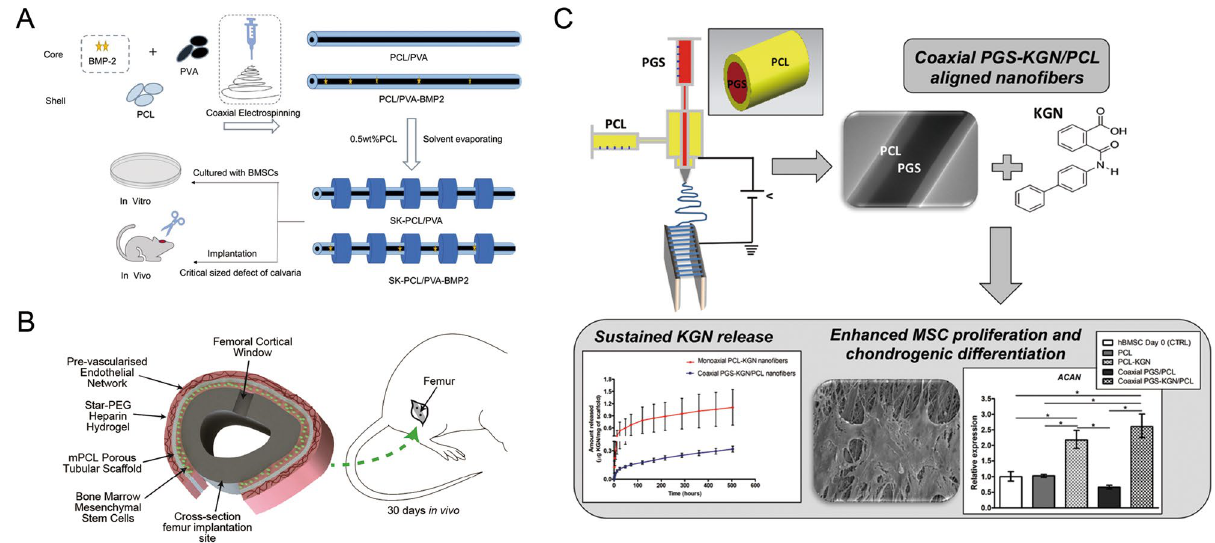
Fig. 3 a Preparation and application of shish-kebab (SK) struc- ture electrospinning scaffold for repairing skull defect in vivo